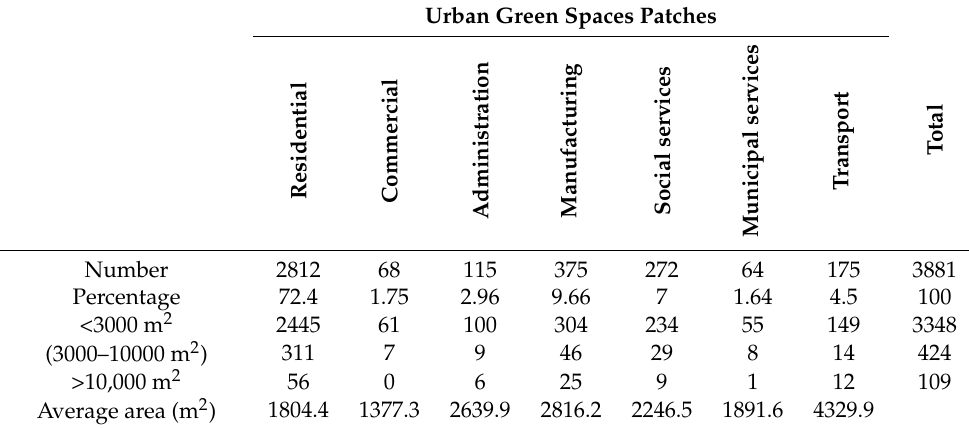
Table 7. Number of fragments and their proportions in the functional urban land use areas in the